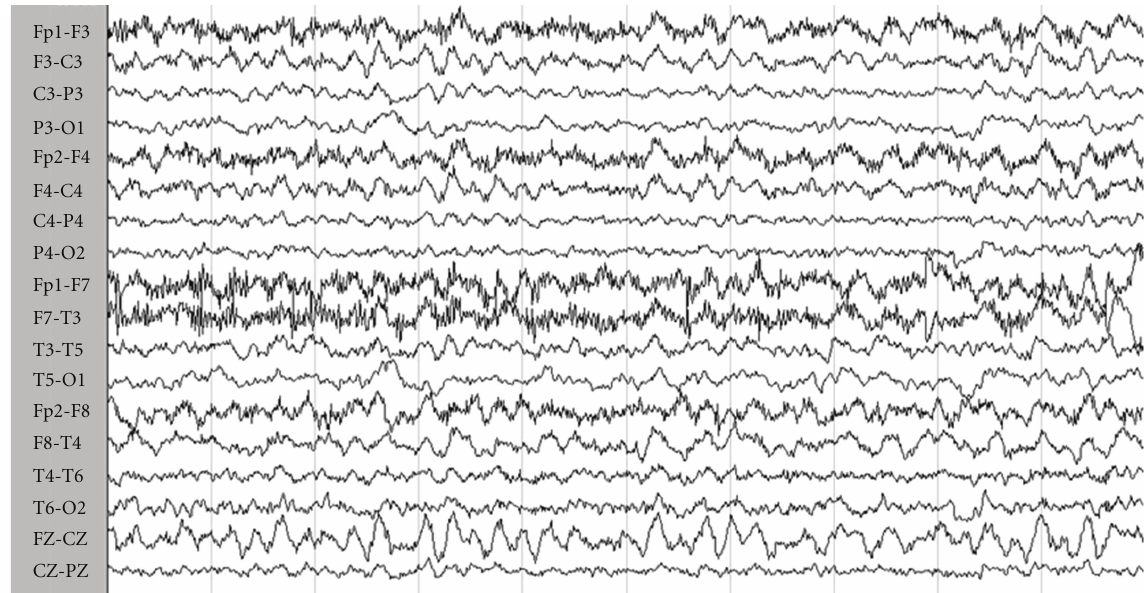
Figure 1: Ictal EEG. The EEG during the episode showed a subcontinuous theta-delta activity with sporadic low-voltage spikes prevalent in the bilateral frontotemporal regions.